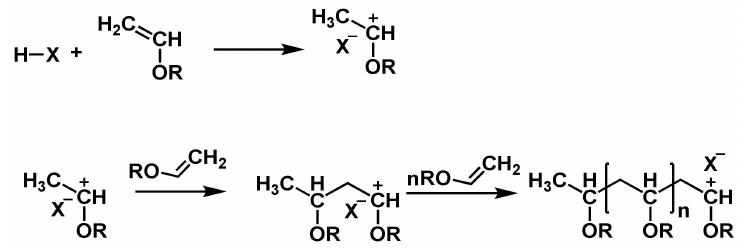
Figure 13. Schematic representation of the cationic polymerization of vinyl